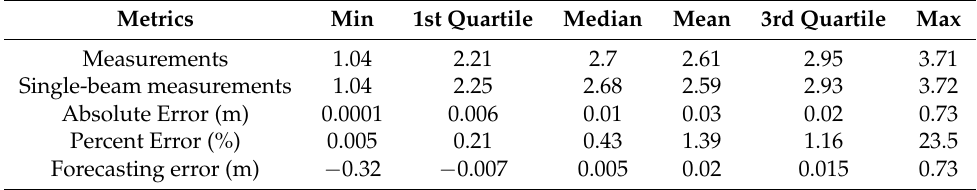
Figure 5. Skill and error metrics between the 100 co-located echosounder and field measurements. ( A ) water depth scatterplot with green line representing a perfect correspondence; ( B ) probability density functions of field measurements (red), and echosounder (blue); ( C ) box and whisker plots display the minimum, first quartile, median, third quartile and maximum value of the absolute error (AE in m), forecasting error (FE in m) and percent error (PE in %). Table 2. Summary of the statistics used for the echosounder independent